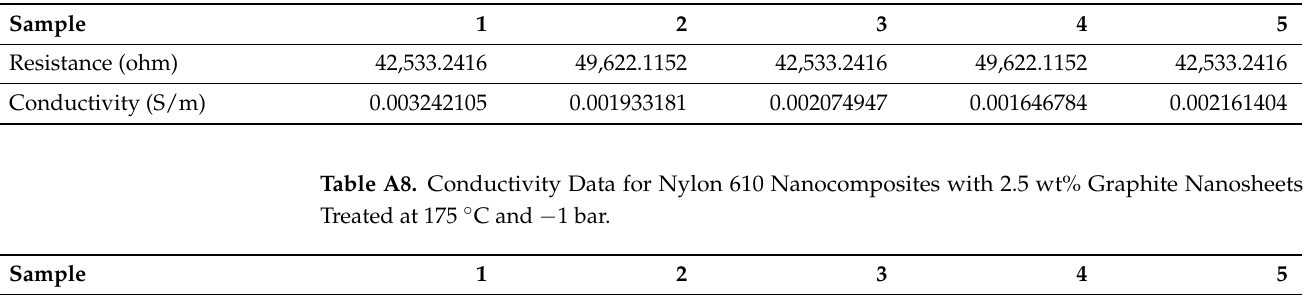
Table A7. Conductivity Data for Nylon 610 Nanocomposites with 1.5 wt% Graphite Nanosheets Treated at 175 ◦ C and − 1 bar.